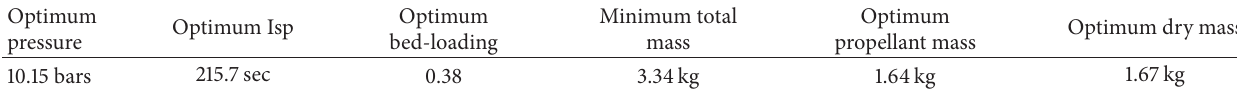
Table 4: Results of multidisciplinary design of hydrazine propulsion system.